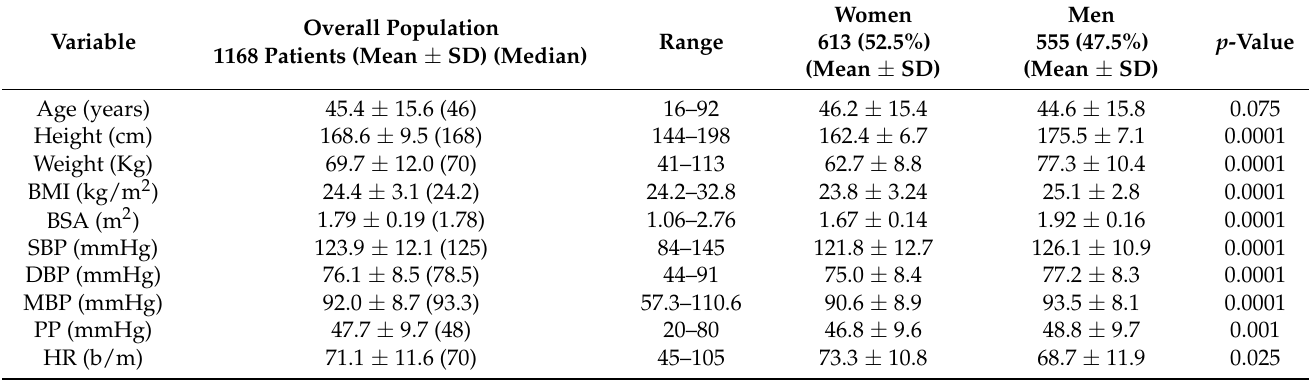
Table 1. Demographic and clinical characteristics of the study